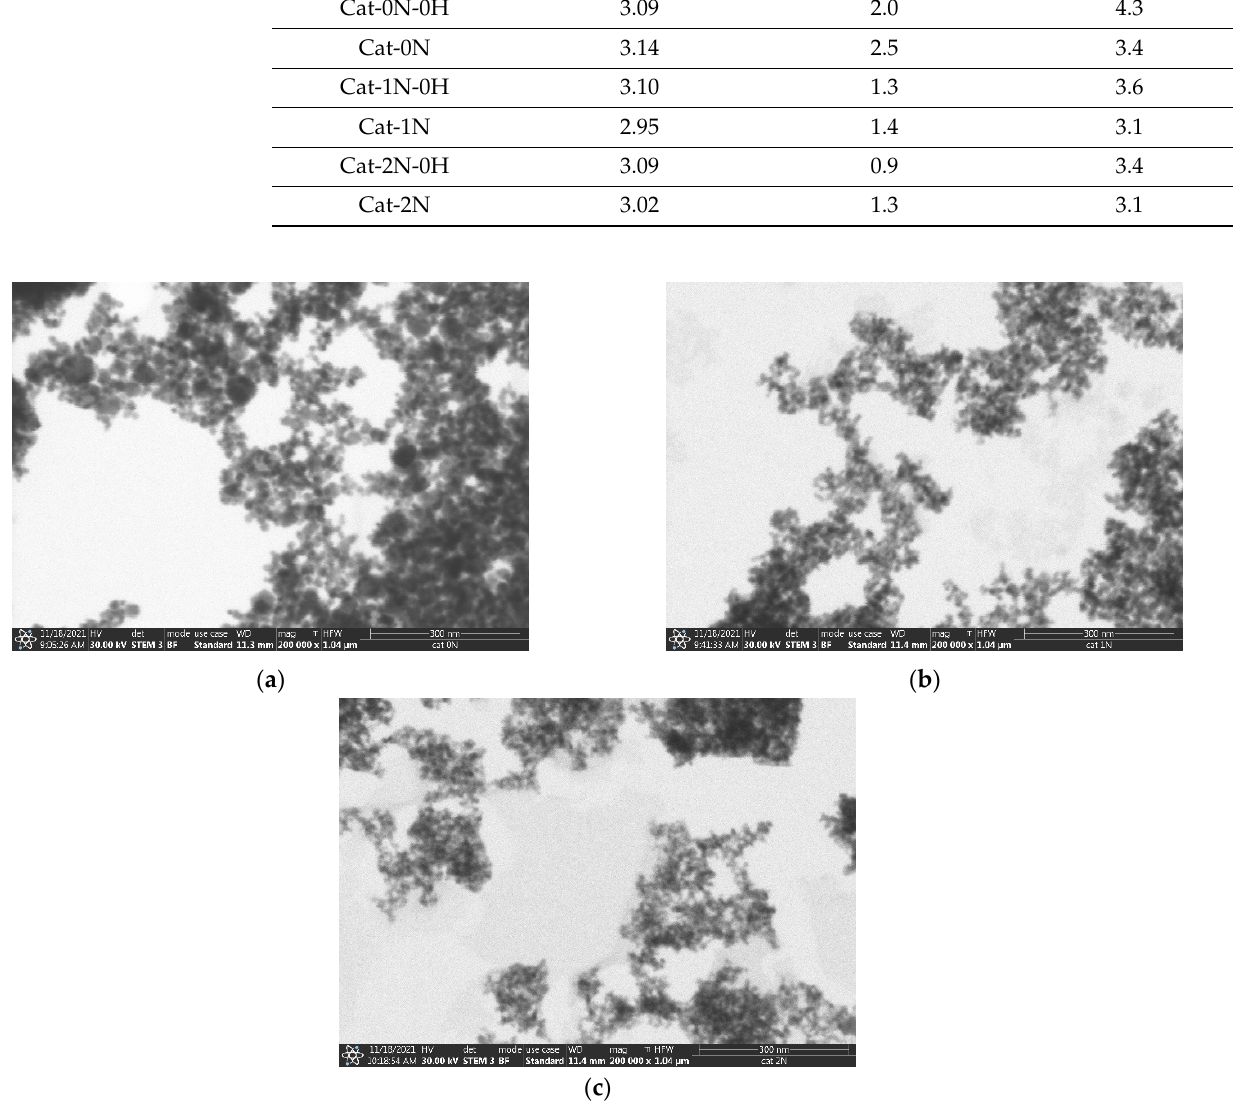
Table 4. The Zn:Cd atomic ratios of the investigated catalysts calculated from the EDS analyses of different areas: A: average values regarding the whole area shown in the SEM pictures, B: the average of some lighter spots, and C: the average of a darker area. Catalyst